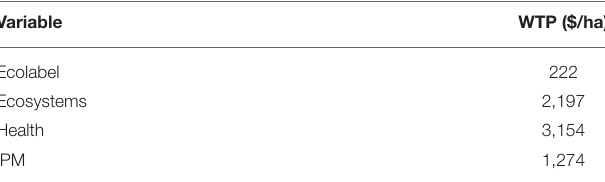
TABLE 5 | Estimates of the willingness to pay among different alternative vegetable farming attributes. Variable Ecolabel Ecosystems